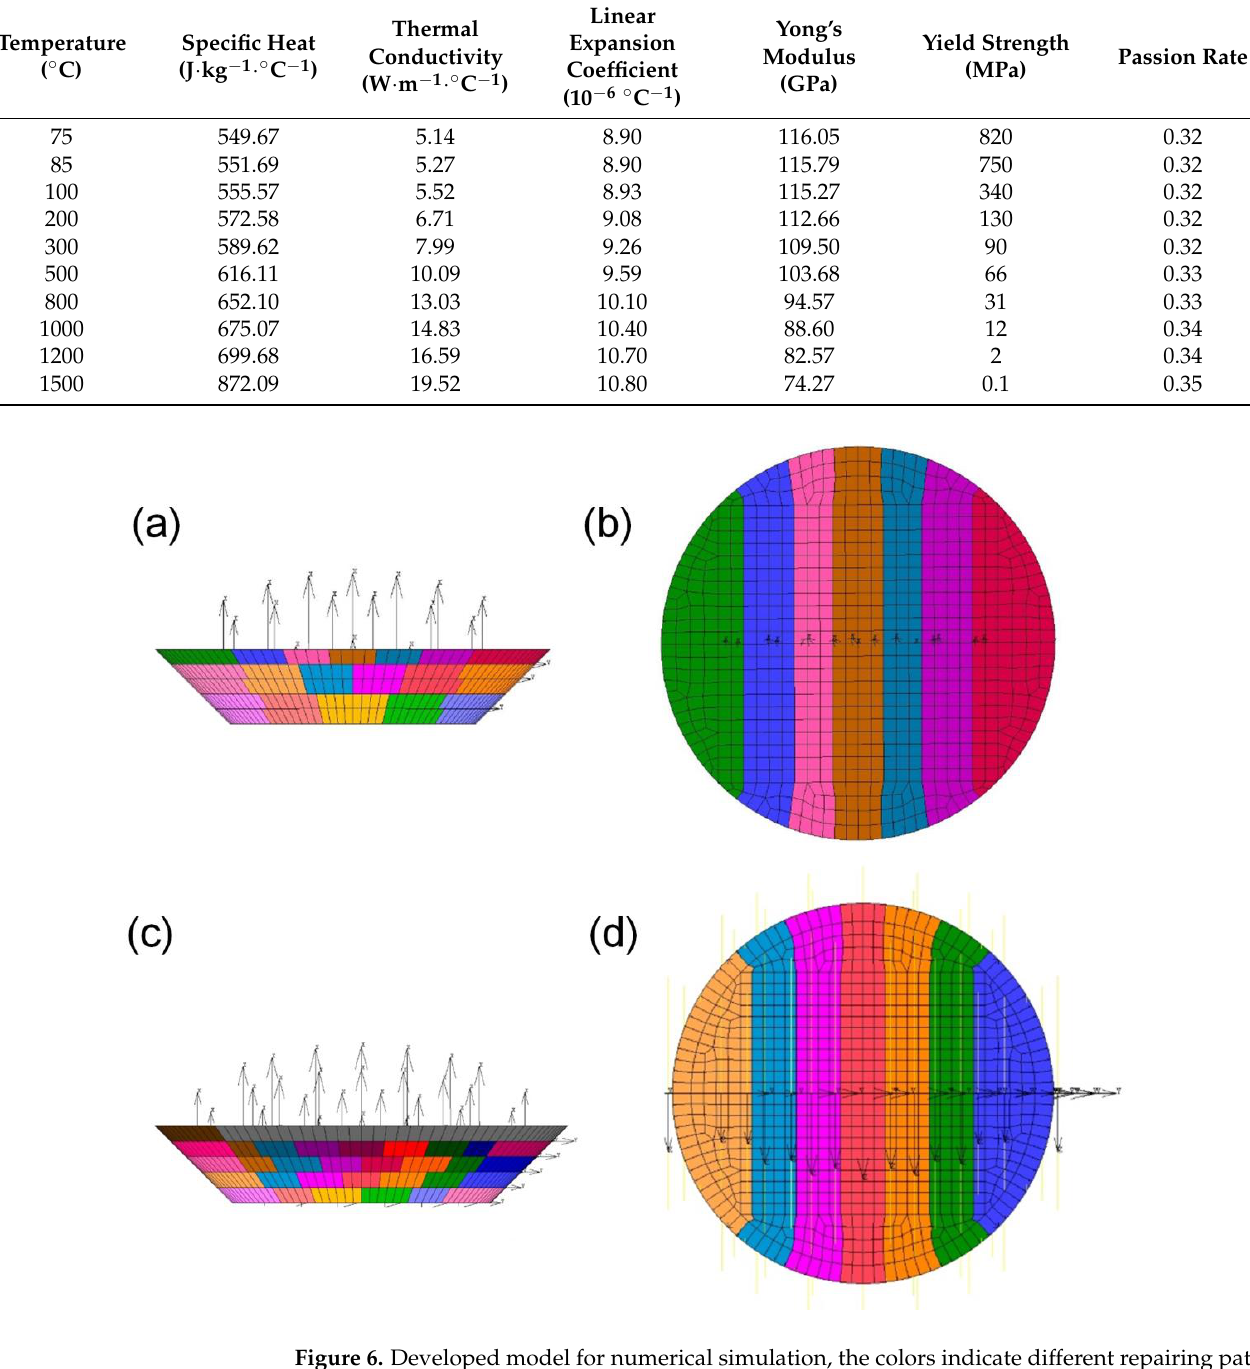
Table 3. Thermal-mechanical properties for TC4 [19].